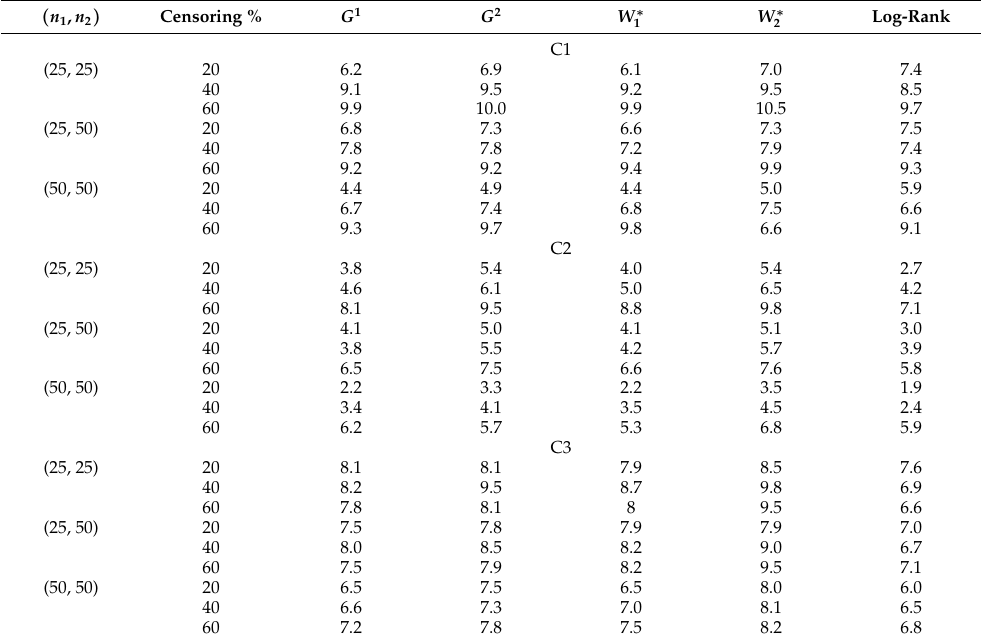
Table 2. Size simulation results (%) at α = 0.05, θ =